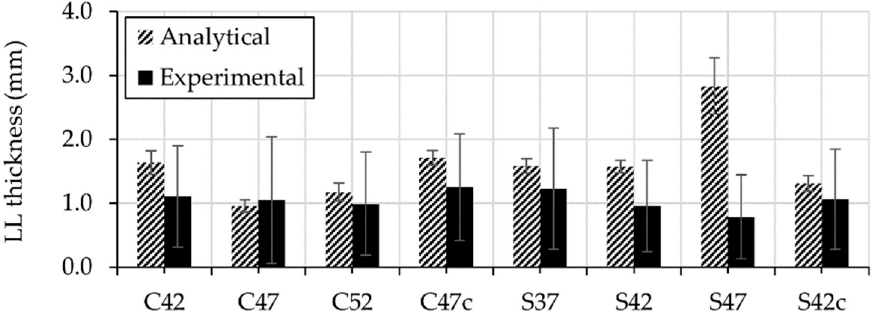
Figure 10. Comparison between experimentally and analytically determined thicknesses of the lubricating layer for all concretes under investigation.